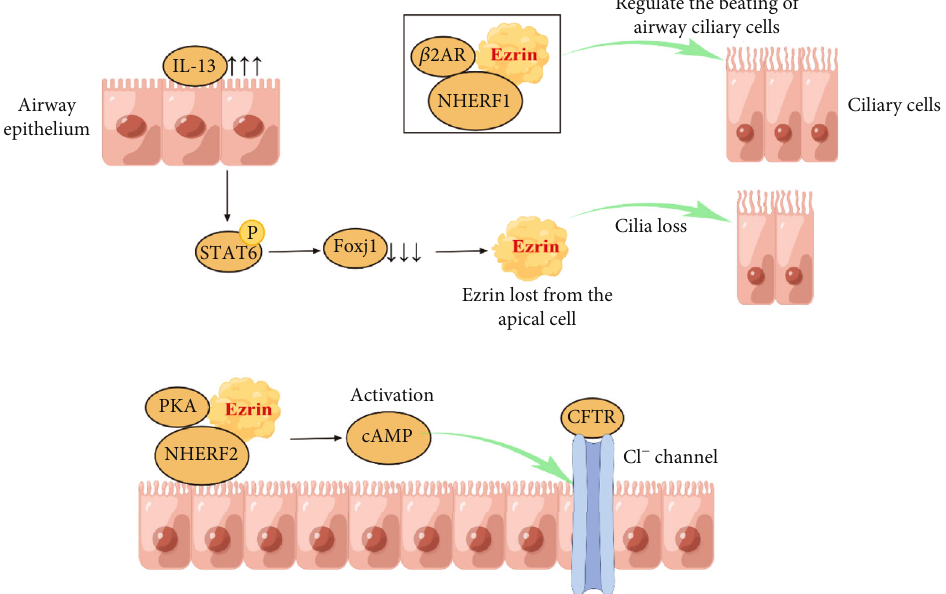
Figure 3: Ezrin and epithelial integrity. Abbreviations: β 2AR: β 2 adrenergic receptor; NHERF1: Na + − H + exchanger regulatory factor; IL- 13: interleukin-13; P: phosphorylate; STAT6: signal transducers and activators of transcription 6; Foxj1: forkhead box protein J1; PKA: protein kinase A; NHERF2: NHE3 kinase; cAMP: cyclic adenosine monophosphate; CFTR: cystic fi brosis transmembrane conductance